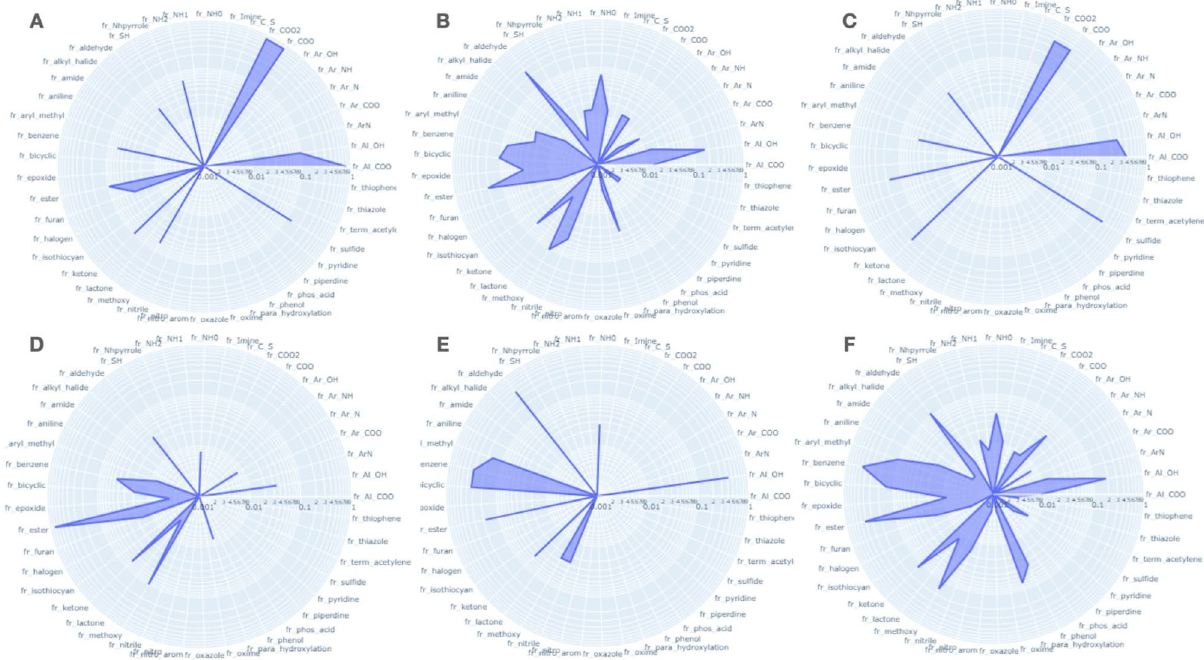
Figure 4. Radar plot based on the frequency of physicochemical properties observed on the set compounds associated to an odor note. ( A ) Acidic, ( B ) Citrus, ( C ) Cheese, ( D ) Apple, ( E ) Muguet, ( F ) Floral. The radarplots were developed with the python package plotly (v.5.3.1): https:// plotly. com/ 61